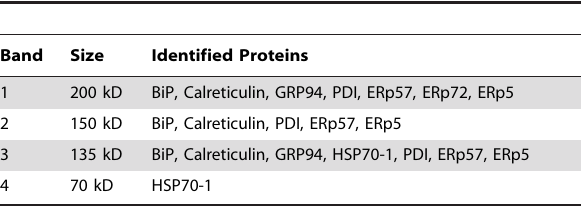
Table 1 . Identification of proteins that are crossed-linked with